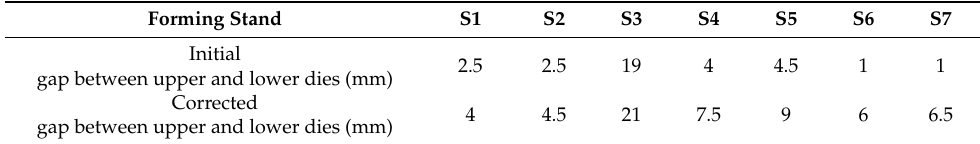
Table 7. Experimental data of the representative